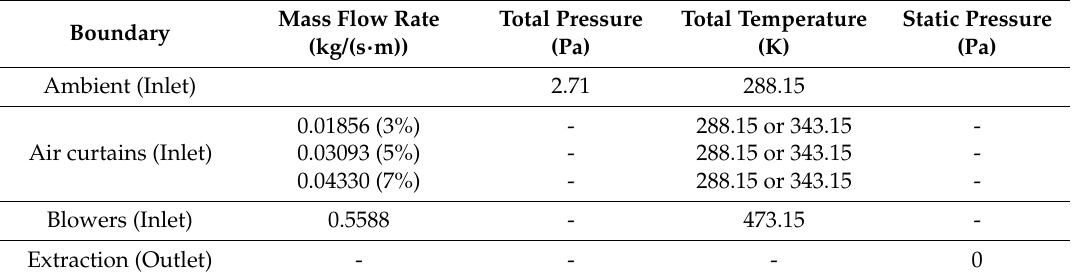
Table 5. Main boundary conditions assigned for CFD